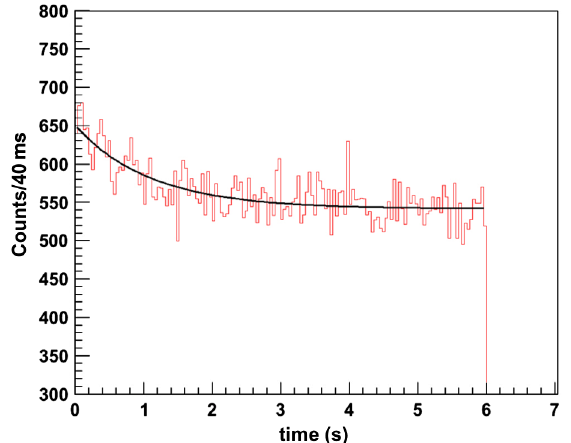
FIG. 15. Decay of 8 B (setup without the collection device). χ 2 =n ¼ 596 . 9 = 597 T ¼ 639 ms in comparison with T 1 = 2 770 ms (from in literature adopted value).